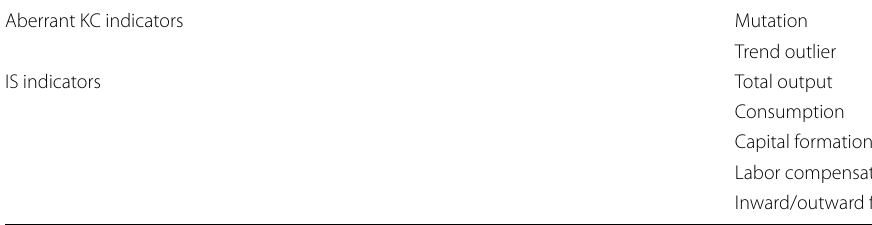
Table 4 Quality evaluation framework for regional IO